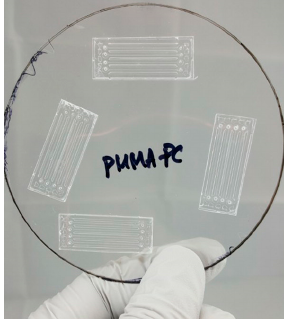
Figure 2. Bonded PMMA microchips on PSC-PC film.